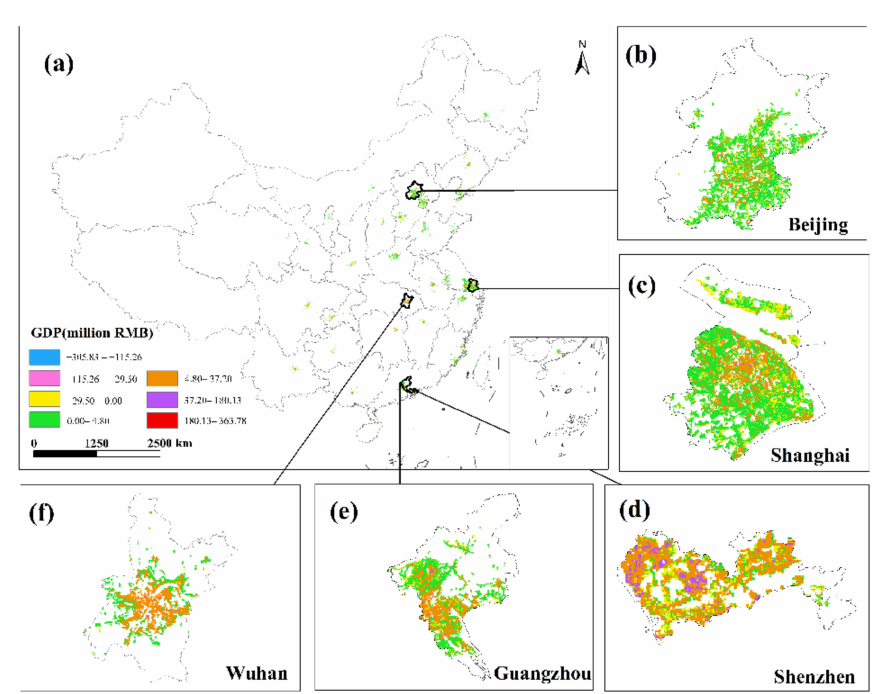
Figure 16. The spatialized result of the sum of GDP in April minus the sum of GDP in March. ( a ) The changes in GDP of 34 cities in China from March to April; ( b ) Beijing; ( c ) Shanghai; ( d ) Shenzhen; ( e ) Guangzhou; ( f )